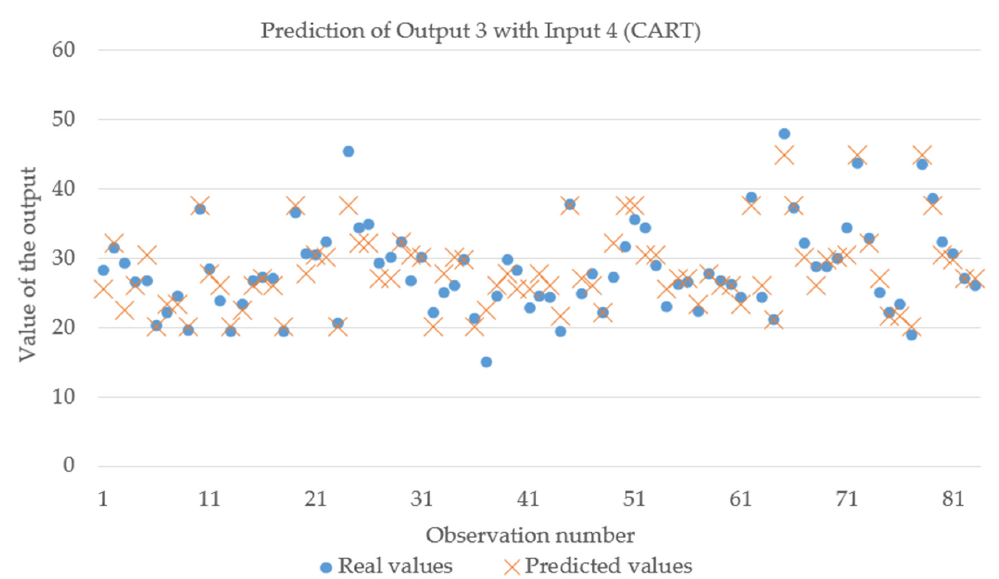
Figure 2. Prediction of Output 3 with the trained CART model from Input 4.